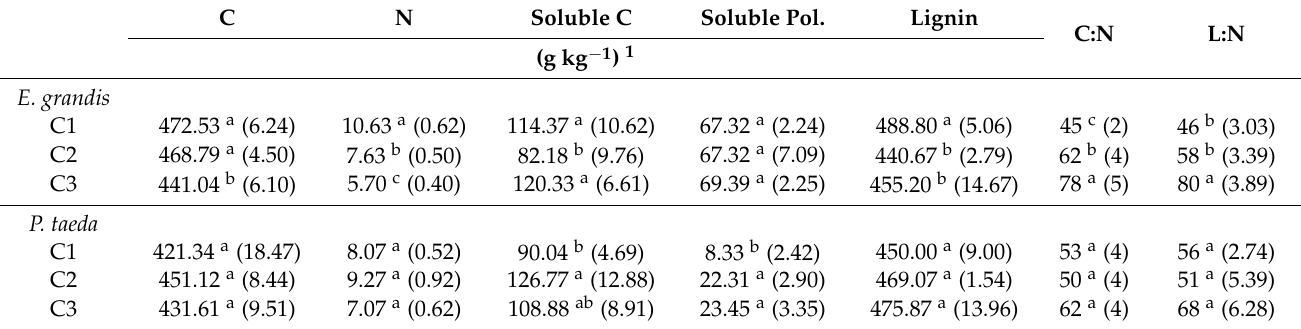
Table 4. Initial characterization of the E grandis and P. taeda litter from the different layers